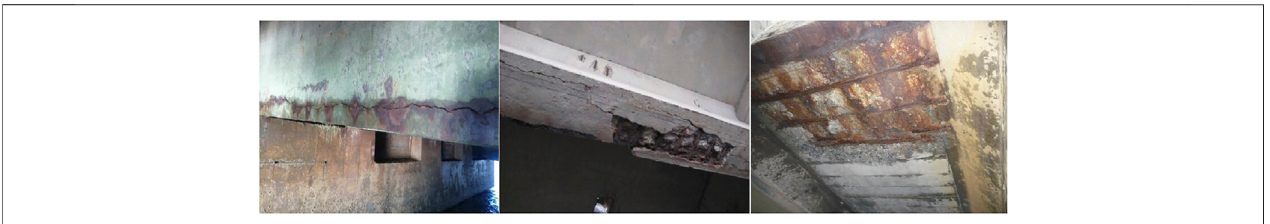
FIGURE 1 | Typical durability damage of harbor structures induced by